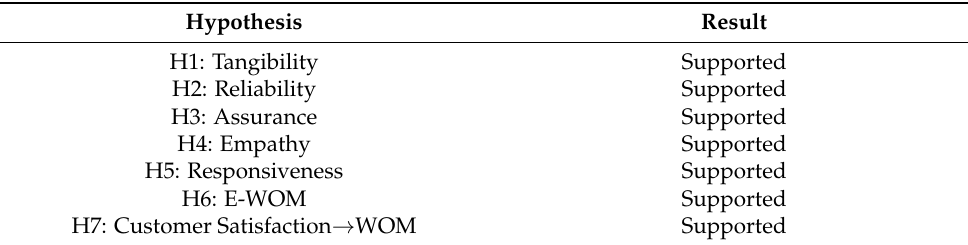
Table 6. Results of